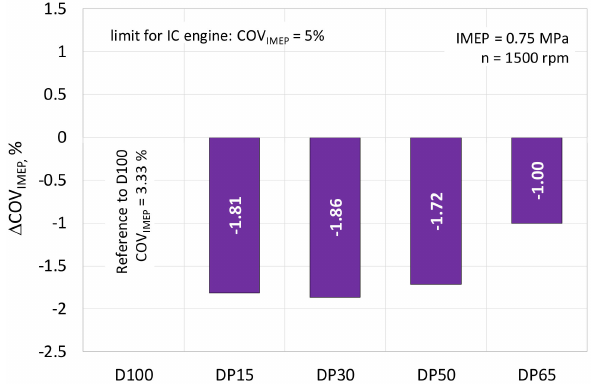
Figure 8. Uniqueness of